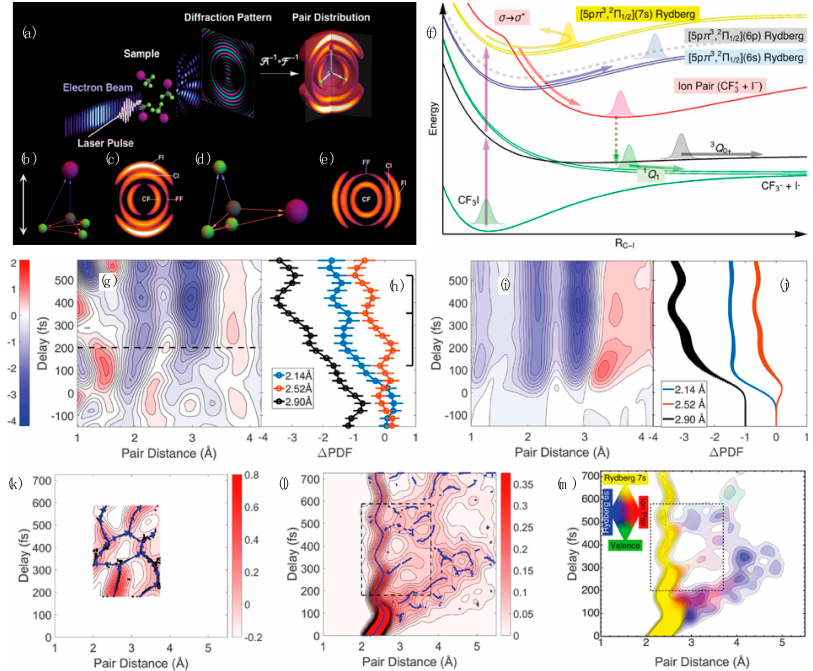
Figure 21. Relativistic ultrafast gas-phase electron diffraction. ( a ) Schematic of relativistic FED experiment. ( b ) A model for a CF 3 I molecule oriented along the laser polarization axis. ( c ) Simulated pair distribution function (PDF) for a molecular ensemble with a cos 2 θ angular distribution. ( d ) A model for a CF3I molecule oriented perpendicular to the laser polarization. ( e ) Simulated PDF for a molecular ensemble with a sin 4 θ angular distribution. The laser polarization is indicated by the double-headed arrow. Gray, light green, and purple represent carbon, fluorine, and iodine, respectively. ( f ) Potential energy surfaces depicting the two-channel excitation in CF 3 I along the C–I bond length coordinate, with major states labeled and reaction pathways marked by arrows. Color coding indicates different electronic states and highlight the complexity of reaction. ( g ) Experimental Δ PDF ⊥ . The dashed line at 200 fs shows a rough separation between contributions from the one- photon and the two-photon channels. ( h ) Experimental time evolution of Δ PDF ⊥ at 2.14, 2.52, and 2.90 Å. A comb illustrates the first two periods of the C–I stretching vibration. ( i ) Simulated Δ PDF ⊥ of the two-photon channel. ( j ) Simulated time evolution of Δ PDF ⊥ at 2.14, 2.52, and 2.90 Å. Figure adapted from Reference [173] with permission from Science AAAS.